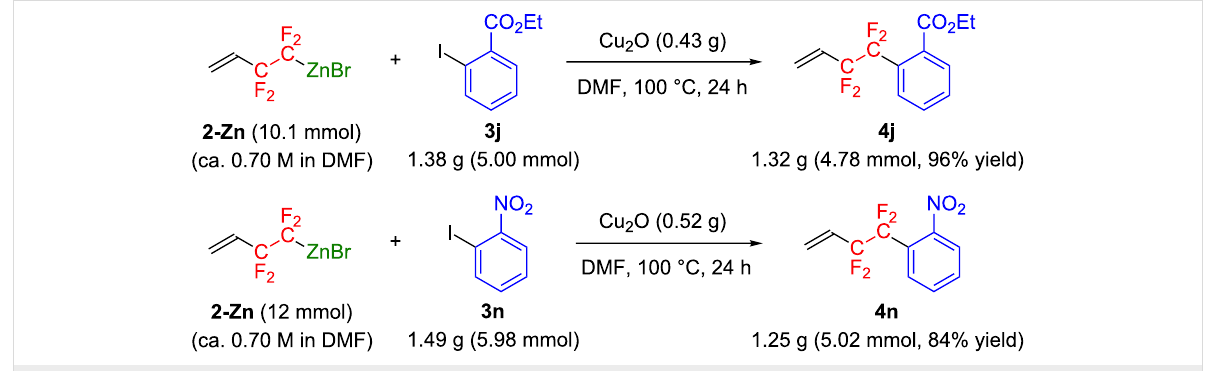
Scheme 2: Multigram-scale cross-coupling of 2-Zn with